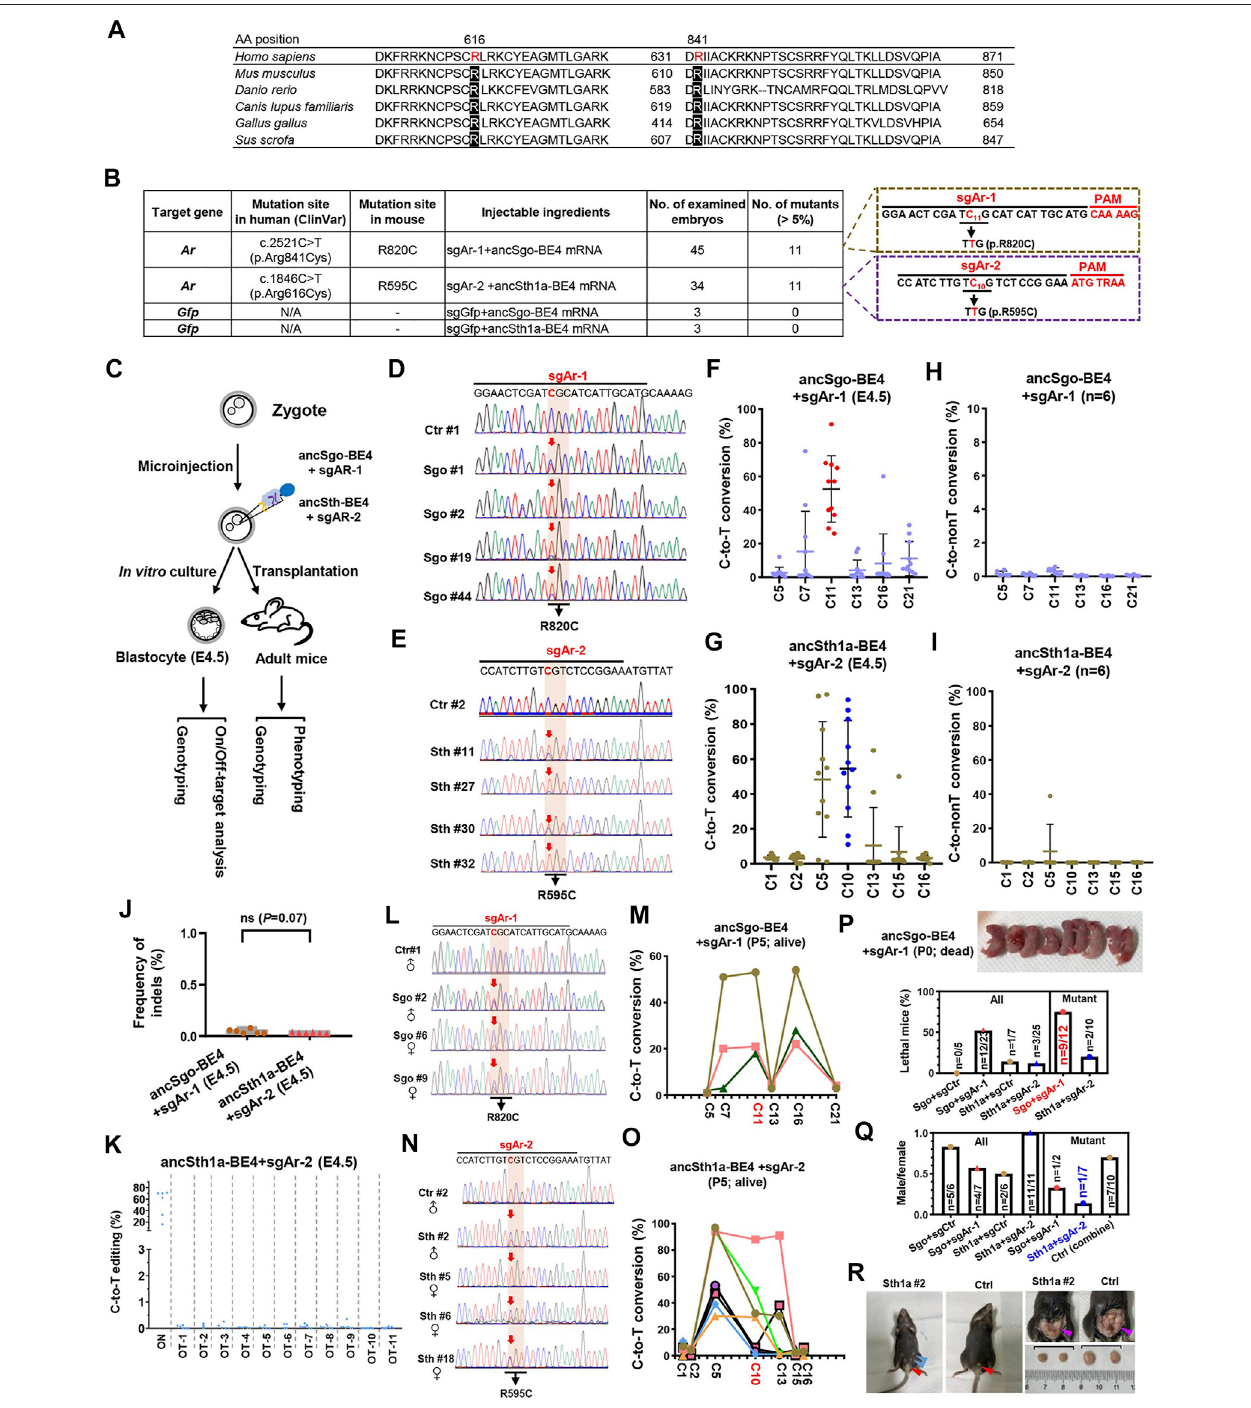
FIGURE 7 | Disease modeling using ancSgo-BE4 and ancSth1a-BE4 in mice. (A) Alignment of potential human pathogenic sites (R616 and R841) in Ar protein sequences among multiple organisms. (B) Summary of gRNA information targeting R820 and R595 in mouse Ar gene. Moreover, the injected reagents, number of examined embryos, and number of mutants with expected mutations ( > 5% in Sanger sequencing results; < 5% was de fi ned as a non-edited embryo) were presented. Control: sgGFP and ancSgo-BE4 or ancSth1a-BE4. (C) Schematic diagram of induction of Ar gene mutations using ancSgo-BE4 or ancSth1a-BE4. Meanwhile, genotyping and phenotyping analyses were performed in E4.5 blastocysts from in vitro culture and adult mice from transplantation. (D,E) Representative sequencing chromatogramsfromfoureditedblastocystsusingancSgo-BE4 (D) orancSth1a-BE4 (E) .Ctrl,control.TargetedC-to-Tconversionswerehighlightedinredarrows.The codon mutations at target sites are presented under the DNA sequences. (F,G) The C-to-T conversion ef fi ciencies of edited mouse E4.5 blastocysts at gRNA targeting